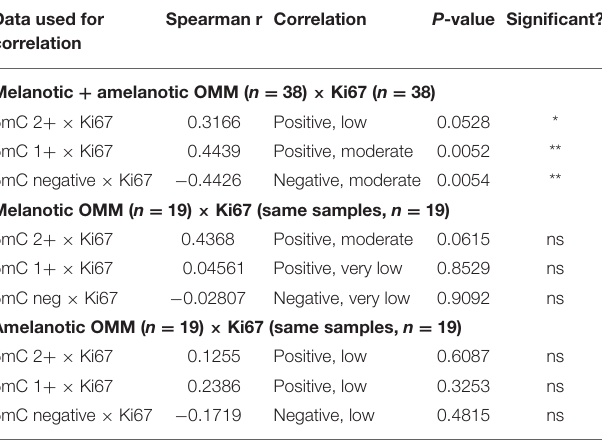
TABLE 4 | Summary of the Spearman’s correlation analysis of the 5mC data and Ki67 positive nuclei in melanotic and amelanotic OMM. Data used for